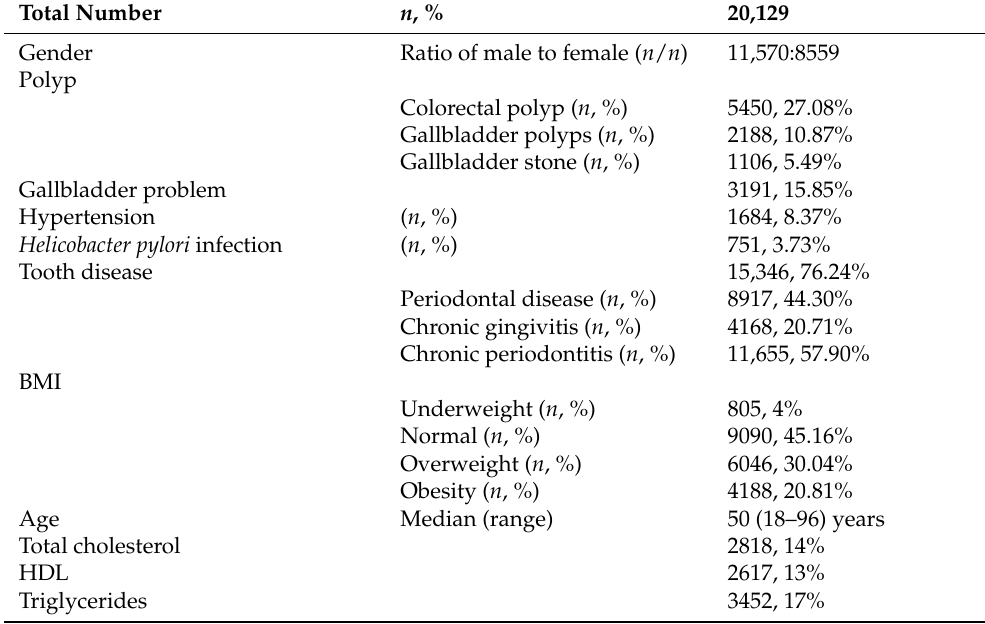
Table 1. Participants’ clinical